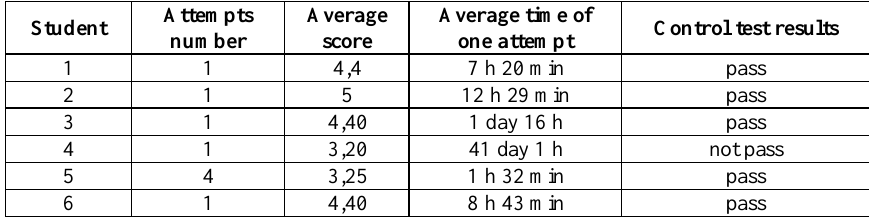
Table 3. Results of the training and control tests (maximum score: 5) on the topic «Differential equations of the first